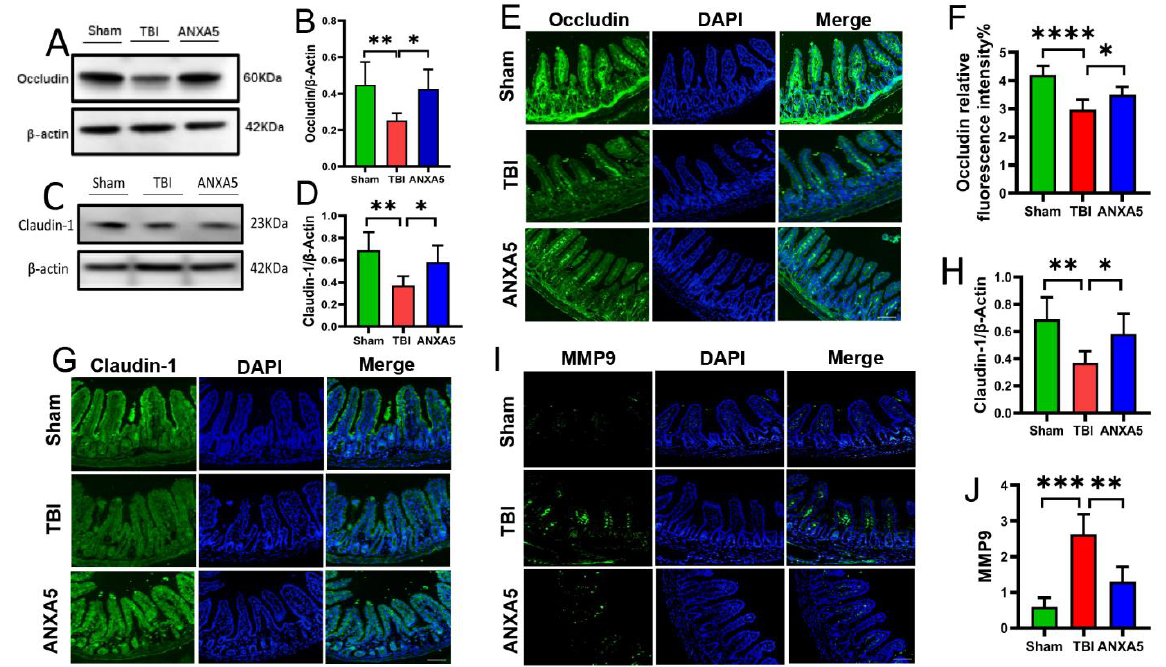
Figure 2. ANXA5 attenuated tight junction protein damage and inhibited MMP-9 activity in the intestine after TBI. ( A – D ) Western blotting showed that the expression levels of occludin and clau- din-1 were significantly reduced on day 2 after TBI, but they were preserved after ANXA5 treatment ( n = 6 mice/group). ( E – H ) Immunofluorescence analysis was performed to quantify occludin and claudin-1 protein expression in more detail. The mean fluorescence intensities of occludin and clau- din-1 proteins (in green) in the TBI group were significantly weaker than in the sham group, and ANXA5 treatment reversed these changes (scale bar = 100 μm, n = 6 mice/group). ( I , J ) Immunoflu- orescence showed that ANXA5 significantly reduced MMP-9 expression in the intestine (in green) induced by TBI ( n = mice/group). Data are shown as mean ± SD. * p < 0.05, ** p < 0.01, *** p < 0.001, **** p <